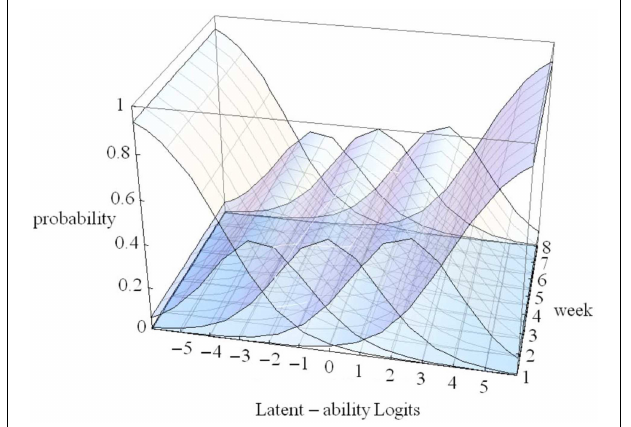
FIGURE 6 | 3D-Overlapping waves model with item characteristic curves for one participant as